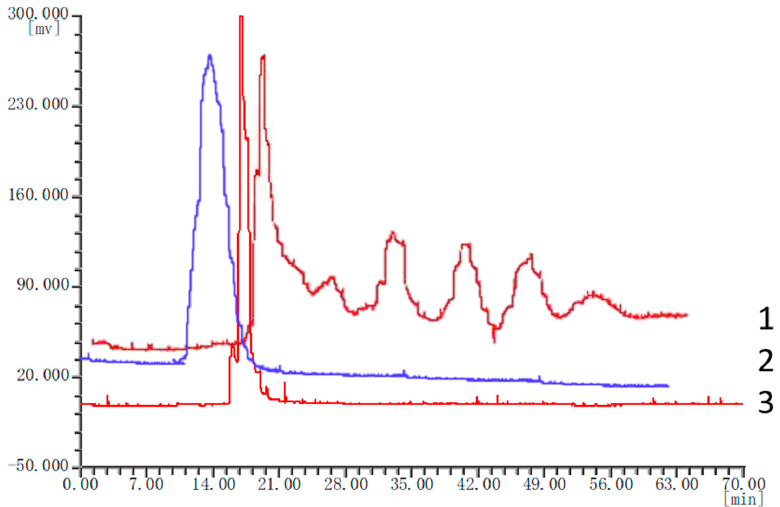
Figure 5. HSCCC chromatogram of Psoralea corylifolia L. ( 1 ), Abutilon theophrasti Medic ( 2 ), and Crotalaria pallida Ait. ( 3 ).